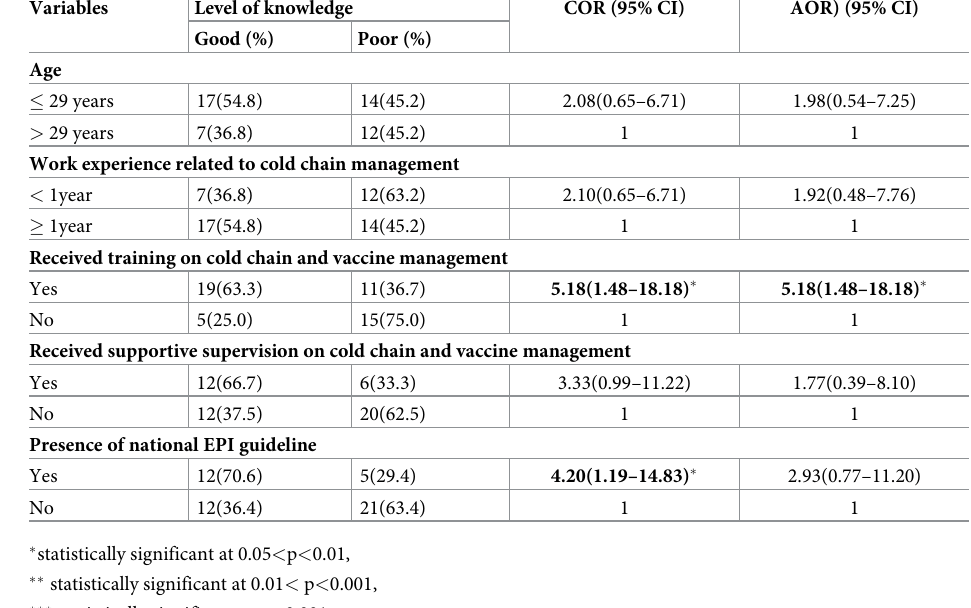
Table 5. Logistic regression analysis of selected variables with knowledge of study participants on cold chain and vaccine management in primary health care facilities of Tigray region, Northern Ethiopia, 2019(N = 50).